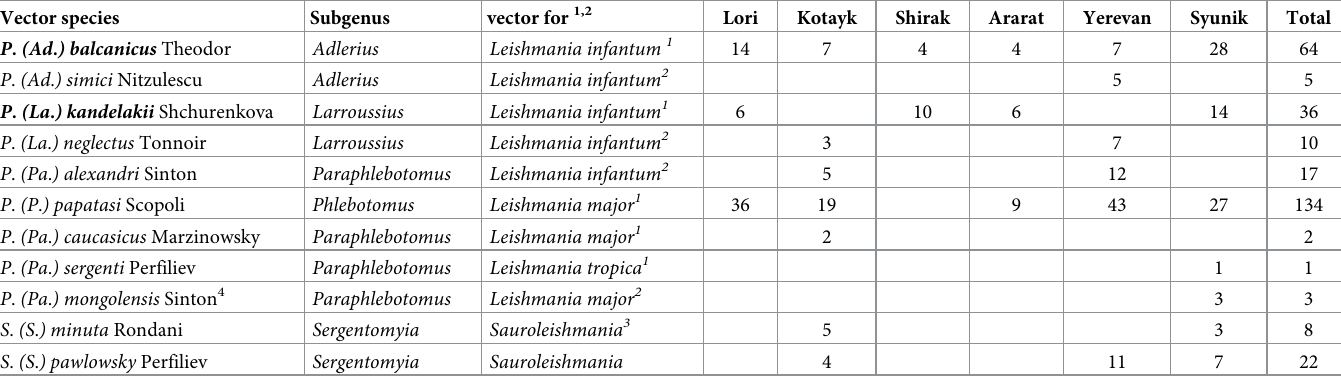
Table 5. Overview of sand fly species and the number of respective collected specimens in the surveyed districts. Vector